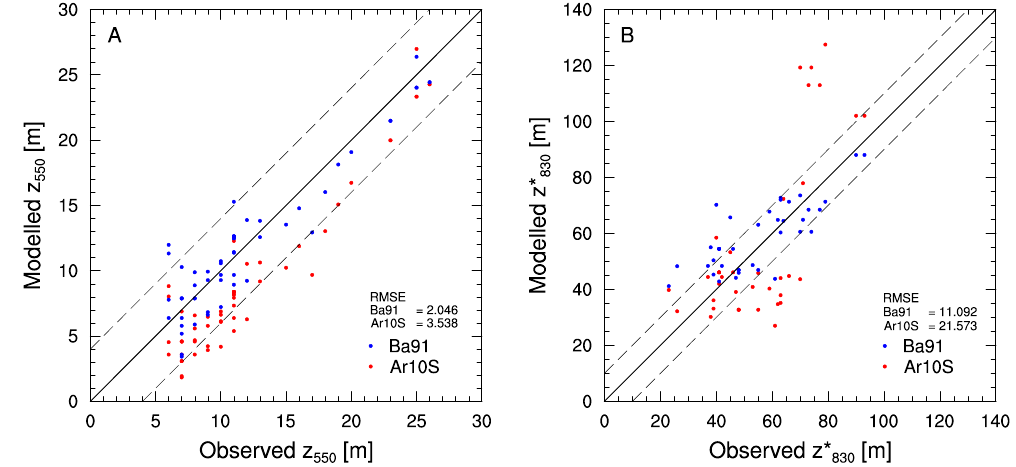
Fig. 4: Modelled vs observed depth of the ρ = 550 kg m − 3 (A) and ρ = 830 kg m − 3 (B) levels, for the densification expressions of Ar10S and Ba91.